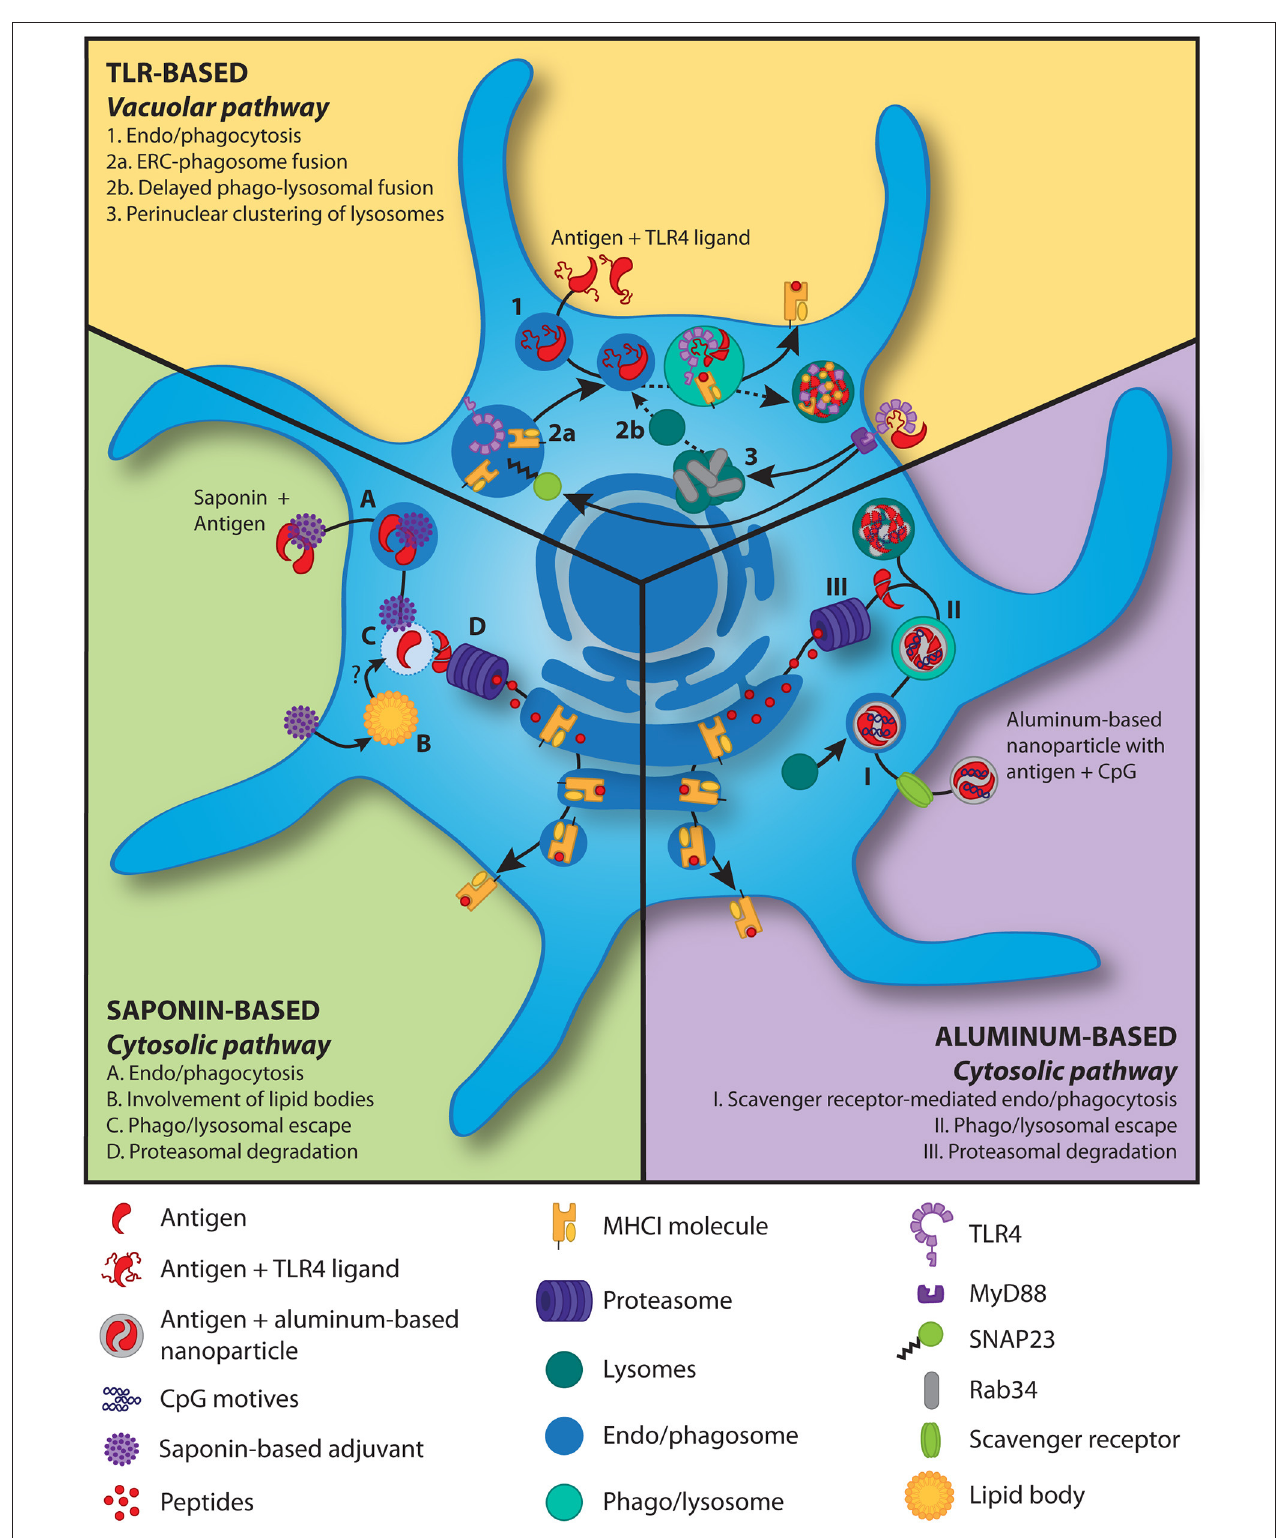
FIGURE 1 | Models for antigen cross-presentation mechanisms induced by adjuvants in DCs. TLR-based adjuvants : In the presence of TLR triggering, antigen is taken up by the DCs and delivered to phago/lysosomes (1). The MHCI molecules and TLR4 within the endosomal recycling compartment are shuttled into the phago/lysosome (2a) following TLR4 signaling induced phosphorylation of SNAP23 (85). TLR4 signaling further induces perinuclear clustering (3) of lysosomes in a